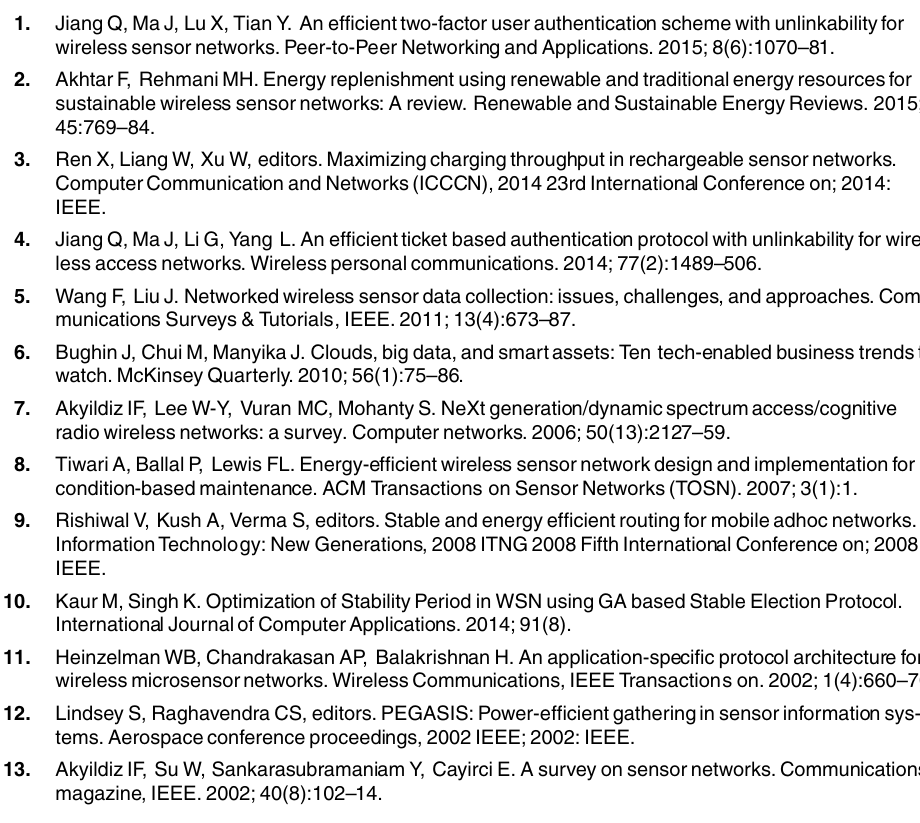
S1 Table. This is the S1 Table. S2 Table. This is the S2